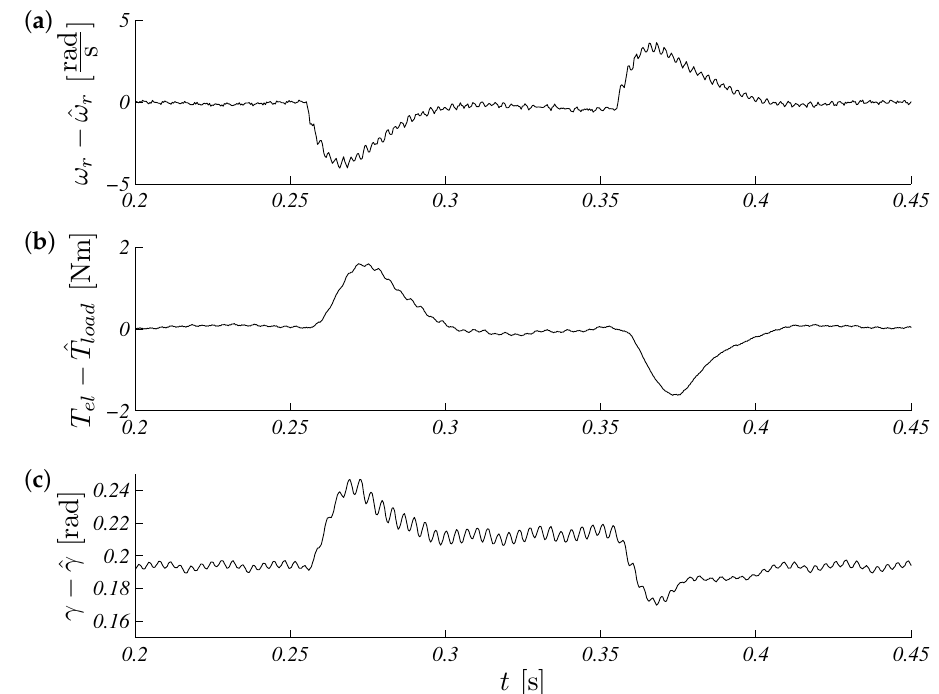
Figure 10. Unscented Kalman filter estimation speed ( a ), torque ( b ) and position ( c ) errors for load torque T l =